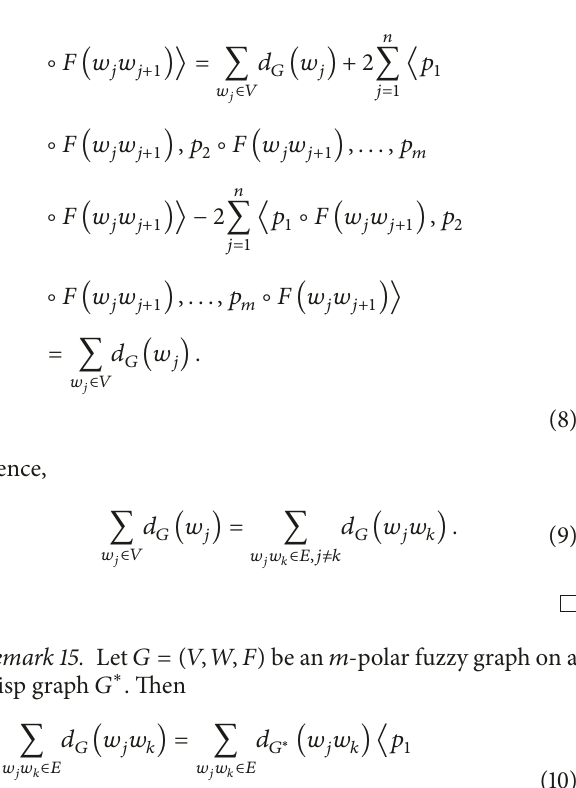
Then, we have 𝑑 𝐺 (𝐾𝐿) = 𝑑 𝐺 (𝐿𝑀) = 𝑑 𝐺 (𝑀𝑁) = (𝑁𝐾) = ⟨0.4, 0.7, 𝑑 𝐺